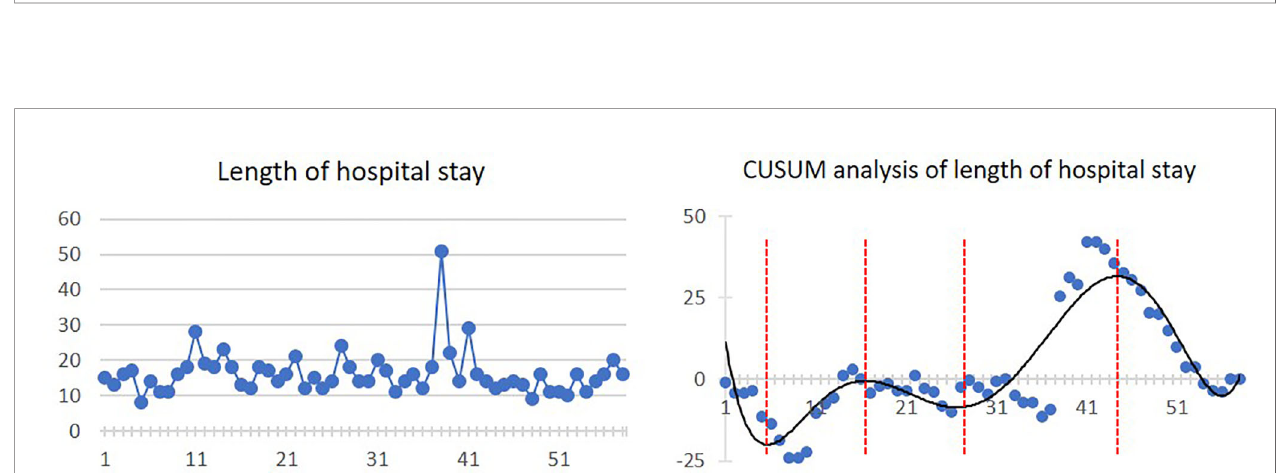
FIGURE 3 | Linear graph and CUSUM analysis of intraoperative blood loss in CAJR applying patient-speci fi c surgical plates. The black line represents the curve of best fi t in a general model with equation, y = 4E − 06 x 6 − 0.0006 x 5 + 0.0274 x 4 − 0.2982 x 3 − 1.1805 x 2 − 94.942 x + 133.67, R ² = 0.7233.